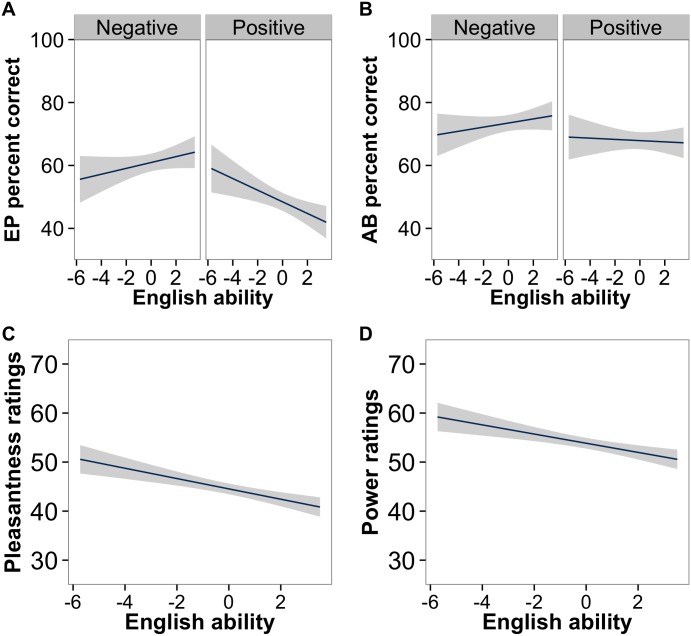
Linear regressions of percent correct responses by English ability for positive and negative emotions in the a) emotional prosody and b) affect burst conditions and of of c) pleasantness and d) power ratings by English ability in the emotional prosody condition.Shaded areas indicate standard deviations.